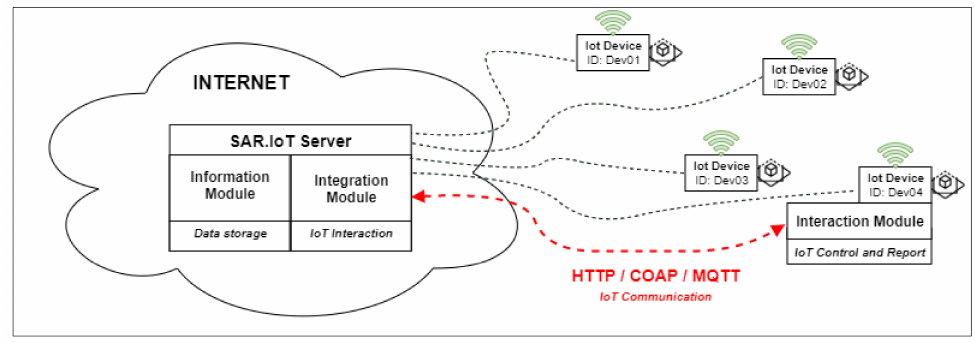
Figure 6. IoT device